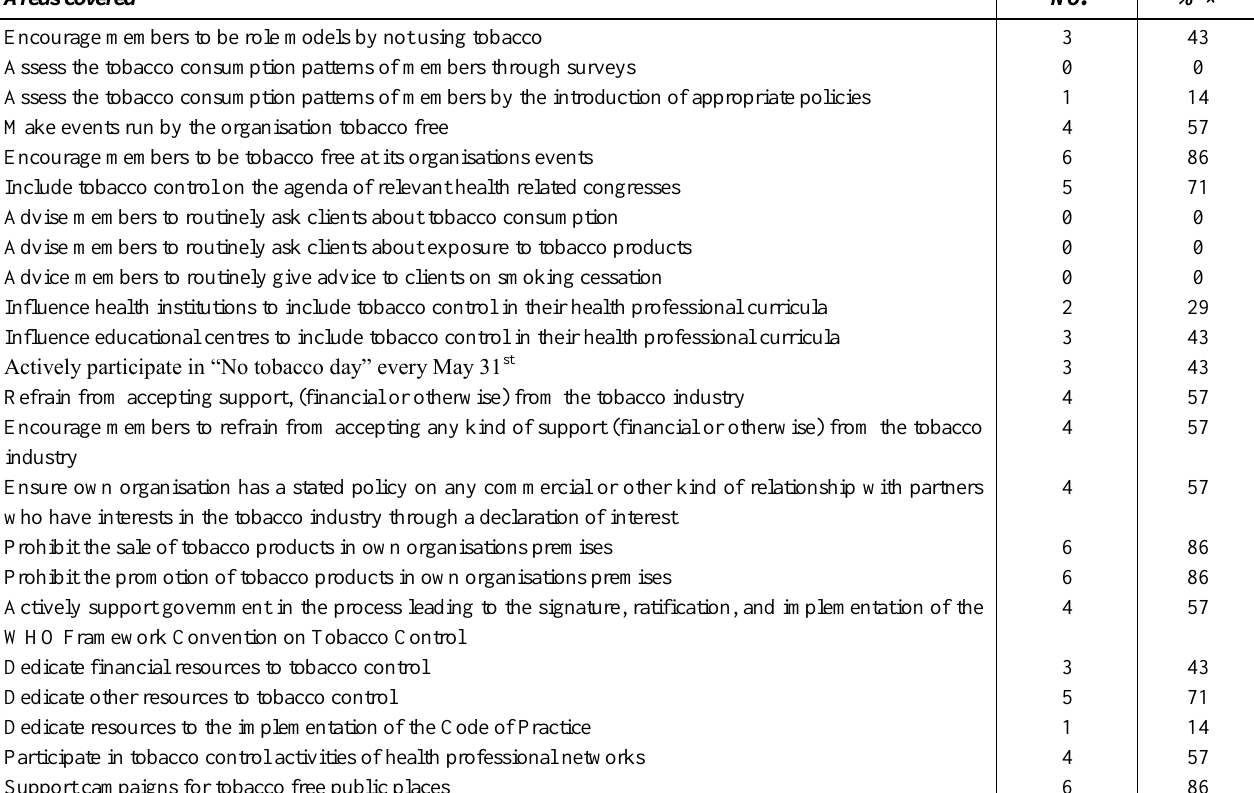
Table 4. Areas covered by policy on tobacco control (based solely upon [9]).